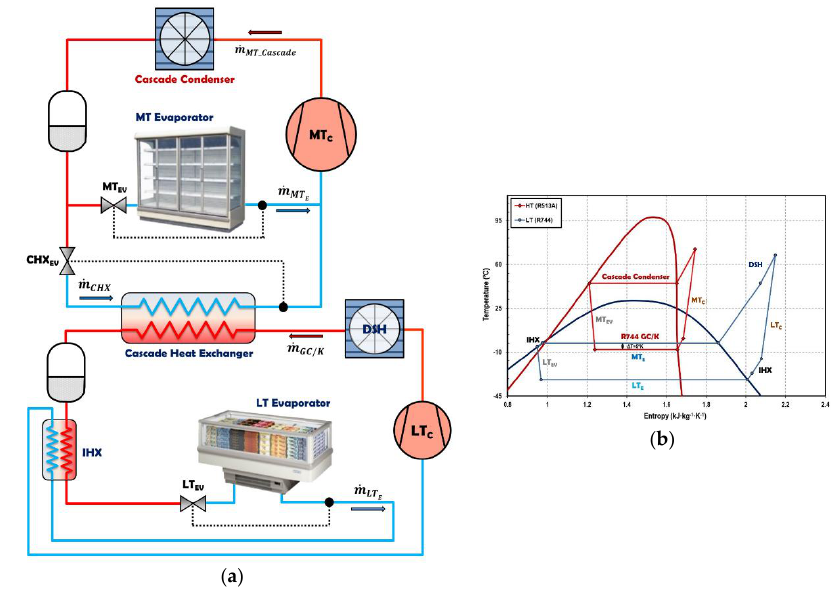
Figure 1. Schematic of a R513A/R744 cascade cycle ( a ) and its T–s diagram ( b ).